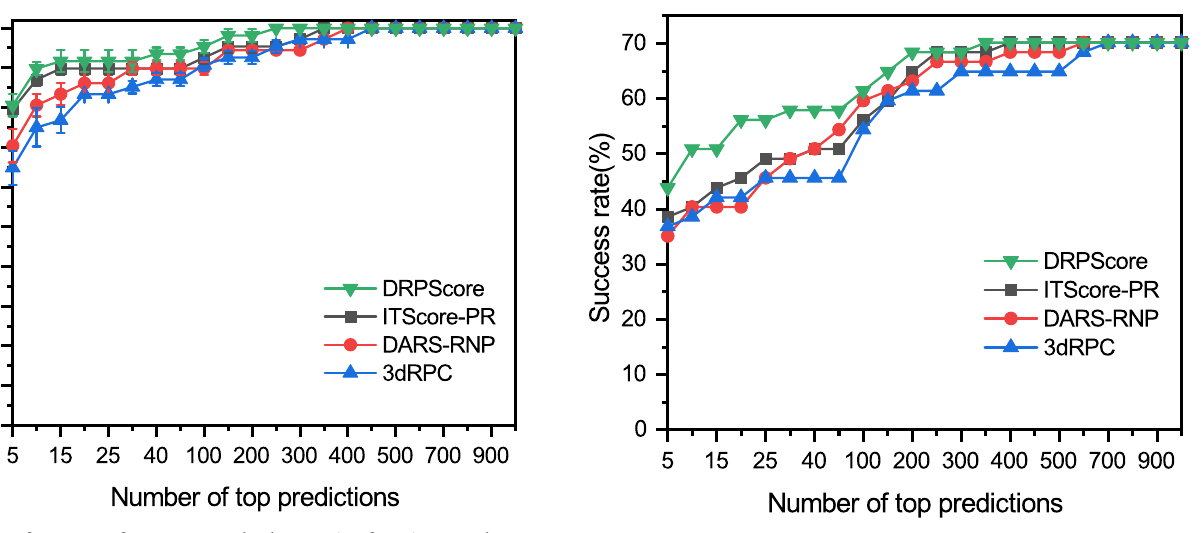
Fig. 2 | The performance of DRPScore and other scoring functions on the unbound-bound and unbound-unbound testing set. The success rates of DRPScore (green inverted triangle), ITScore-PR (black square), DARS-RNP (red circle), and 3dRPC (blue triangle) on the unbound-bound and unbound-unbound testing sets provided by Huang and Zou 37 . Source data are provided as a Source Data fi